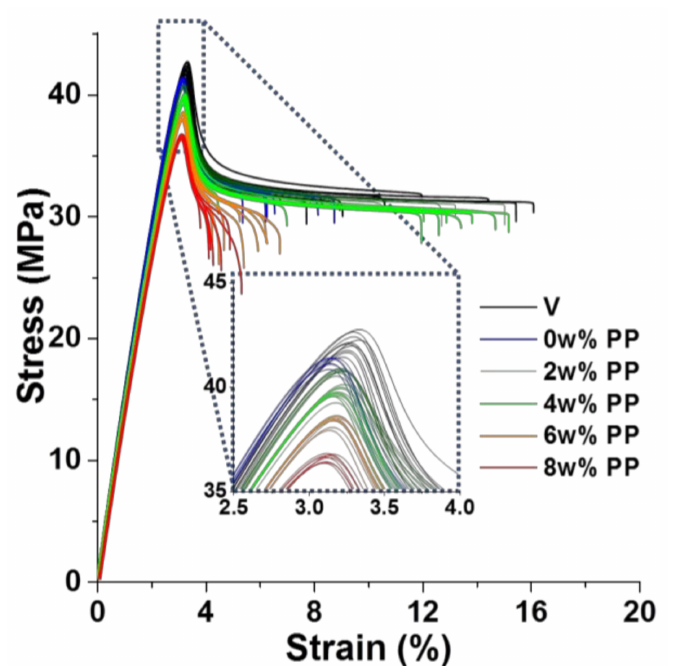
Figure 4. Stress–strain curves of tensile tests on ABS contaminated at increasing rates of PP— magnification on stress peak “V” for directly injected ABS, “0 wt%” went through